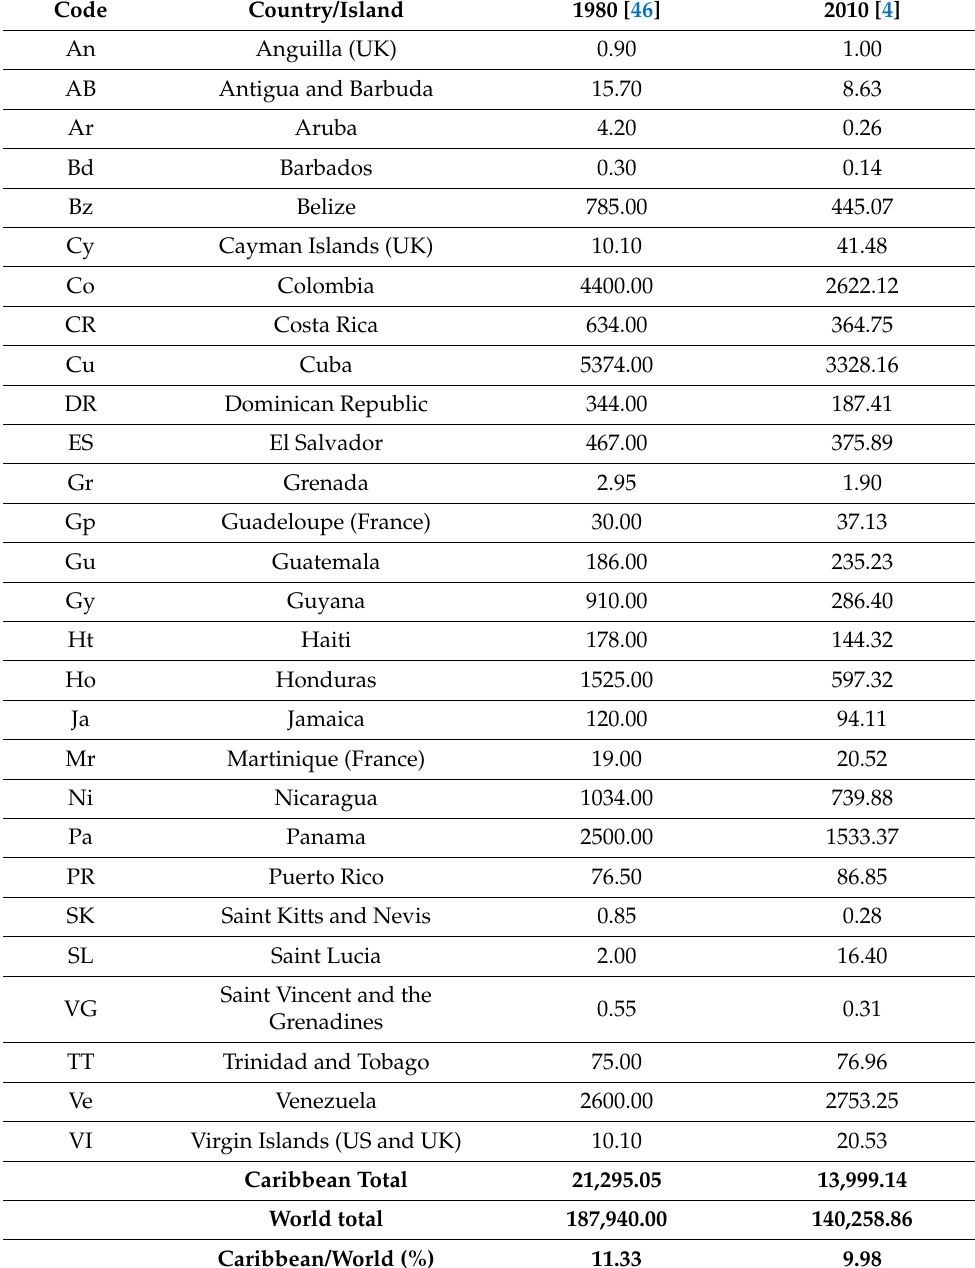
Table 1. Mangrove extent (km 2 ) by country/island in the Caribbean region, comparing the most updated estimates (2010) with those of 1980. Mexico has not been included because most mangroves in this country are outside the Caribbean region, and estimates only for its Caribbean coasts are